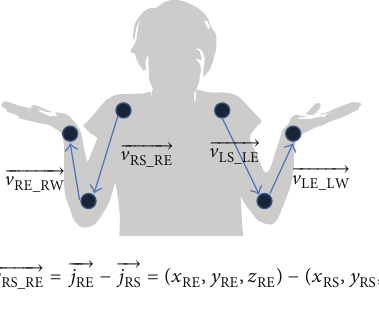
Figure 3: Pose vectors of four arm parts.